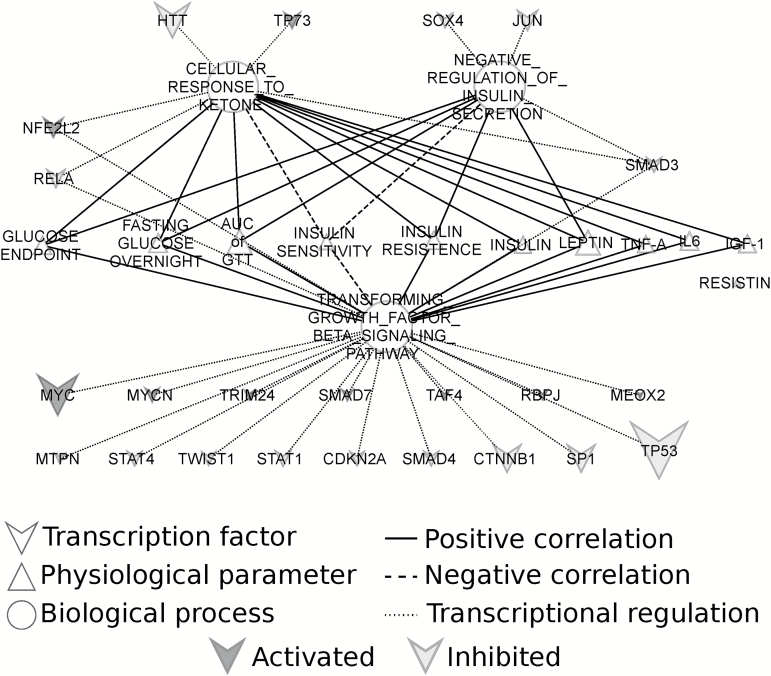
Overview of transcription factors, glucose homeostasis measurements and circulating hormones associated with signaling genes involved in insulin secretion, response to ketones and TGF-β signaling. The full lines represent a positive correlation between expression levels of genes involved in those pathways and physiological measurements. Negative correlations are represented by a dashed line and transcriptional regulation by a dotted line. The activation of transcription factors is represented by grey and the inhibition by black. The node size represents the number of target genes.